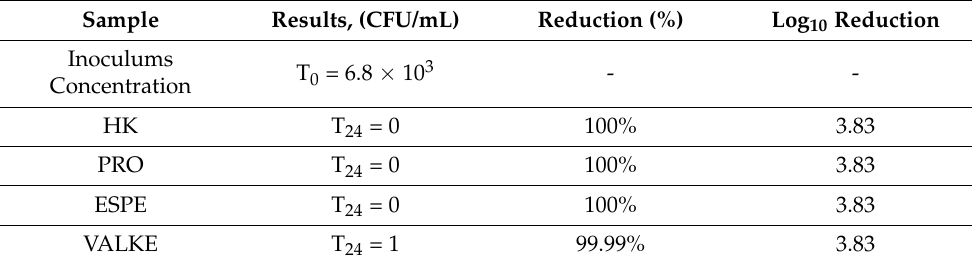
Table 3. The antifungal activity of keratin hydrolysates against Fusarium oxysporum ATCC 48112.